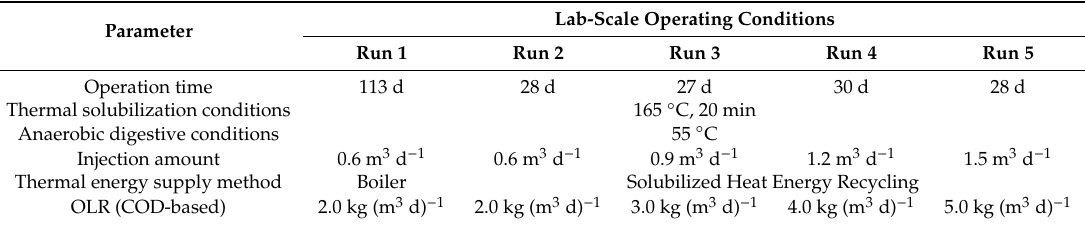
Table 5. Operating conditions of lab-scale experiments. OLR: organic loading rate. Lab-Scale Operating Conditions Parameter Run 1 Run 2 Run 3 Run 4 Run 5 Operation